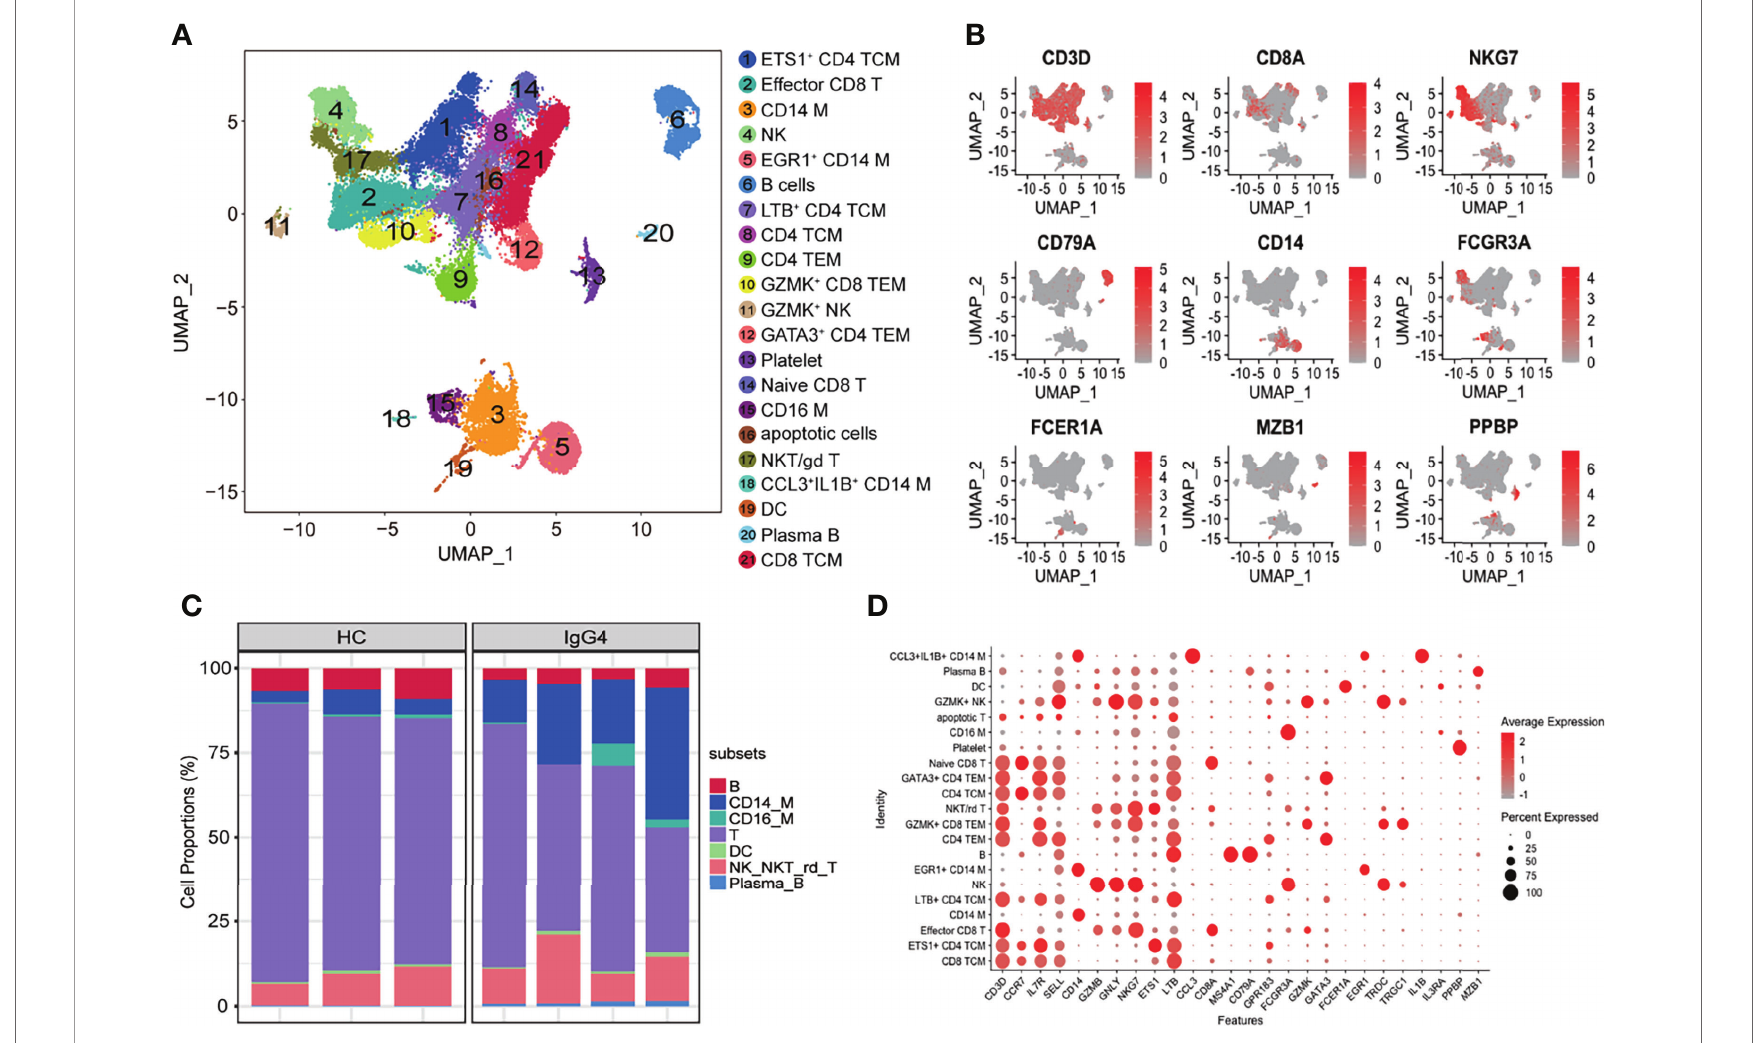
FIGURE 1 | Overview of the clustering and annotation of the sc-RNA sequencing data for IgG4-RD. (A) UMAP representation of 47,219 single cells from HCs (n = 3) and IgG4-RD (n = 4), showing the formation of 21 clusters. (B) Canonical cell markers used to label major cell types represented in the UMAP plot. The legend is labeled in log scale. (C) Bar plot showing cluster abundance of major cell types across all samples. (D) Bubble heatmap showing the selected markers annotating speci fi c cell types. The size of the dot indicates the fraction of expressing cells, colored according to z-score – normalized expression